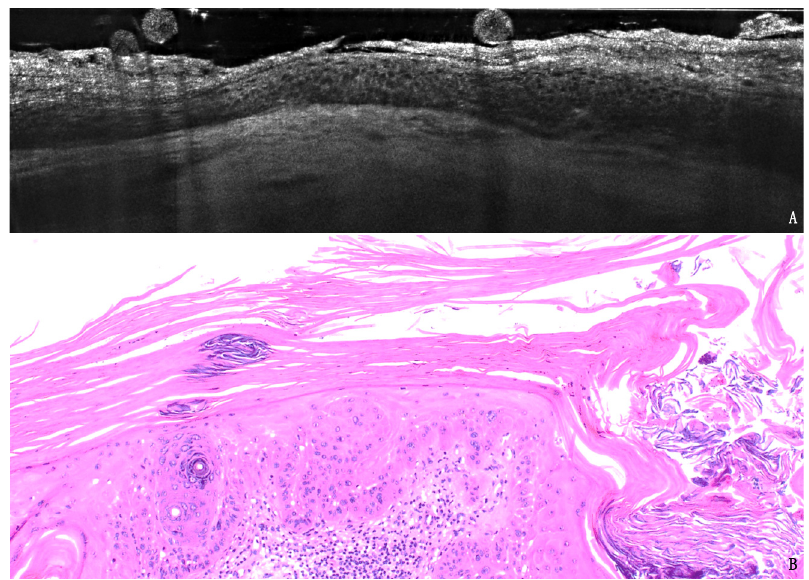
Figure 2. Example of AK lesion with discordant PRO grading between LC-OCT ( A ) and histology (40×, B ): the hypertrophic AK on the scalp of an 85-year-old male patient was graded PROII in LC-OCT and PROIII in H&E, probably because of the diffuse hyperkeratoses impeding the evaluation of the deepest layers of the lesions.